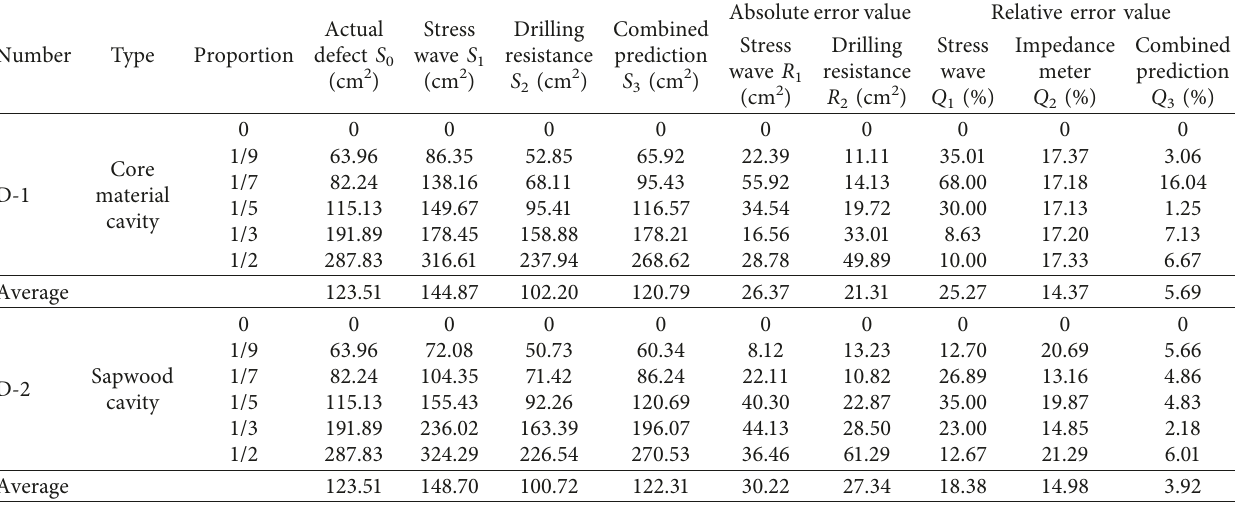
Table 3: Comparison of nondestructive testing